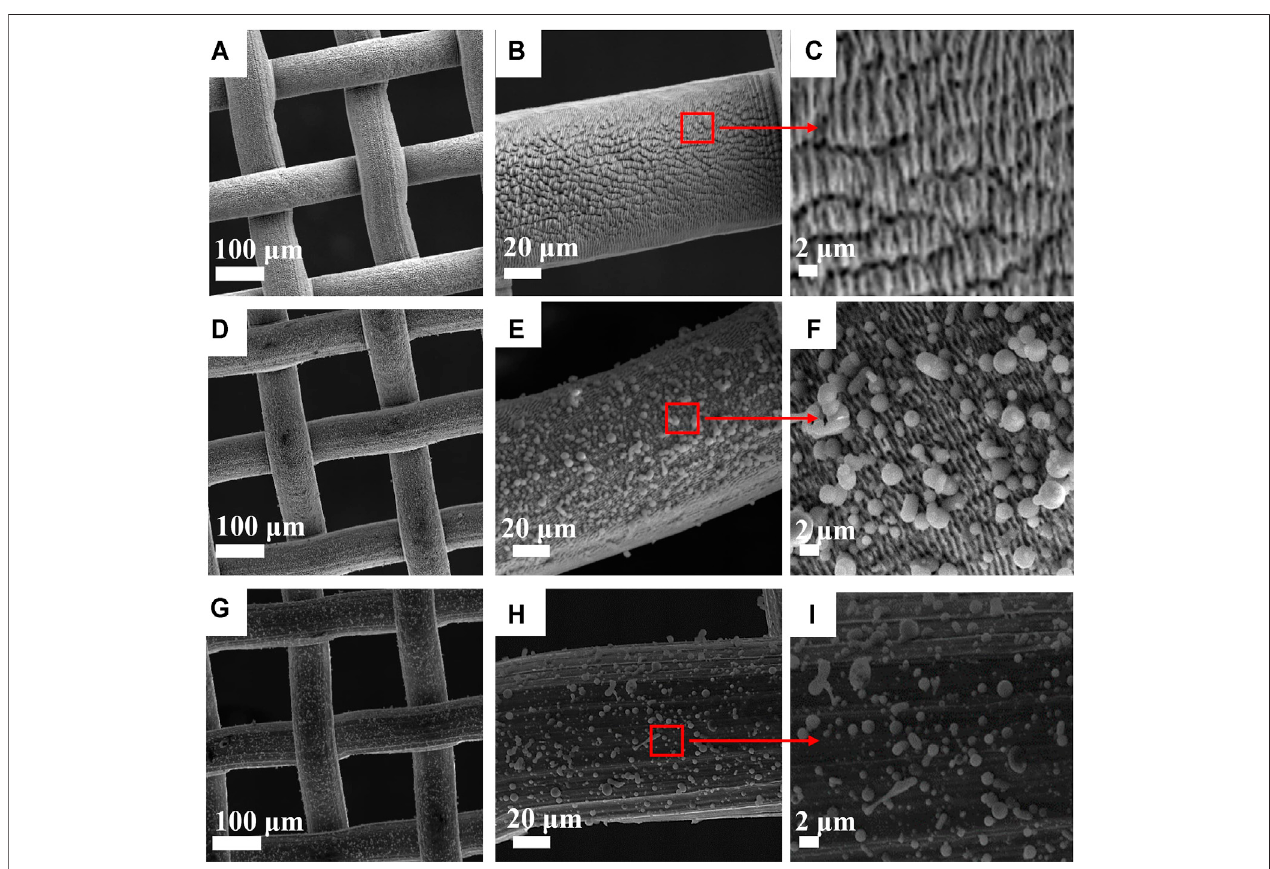
FIGURE 3 | Scanning electron microscopy (SEM) micrograph of SS-100 mesh surfaces. (A – C) Uncoated SS-100 mesh surface structured with laser-induced periodic surface structure (LIPSS). (D – F) Structured SS-100 mesh with LIPSS after coating with zeolite surface. (G – I) Unstructured SS-100 mesh with zeolite-coated surface.